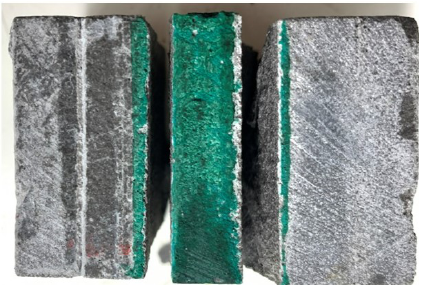
Figure 11. Interfacial shear strength of the